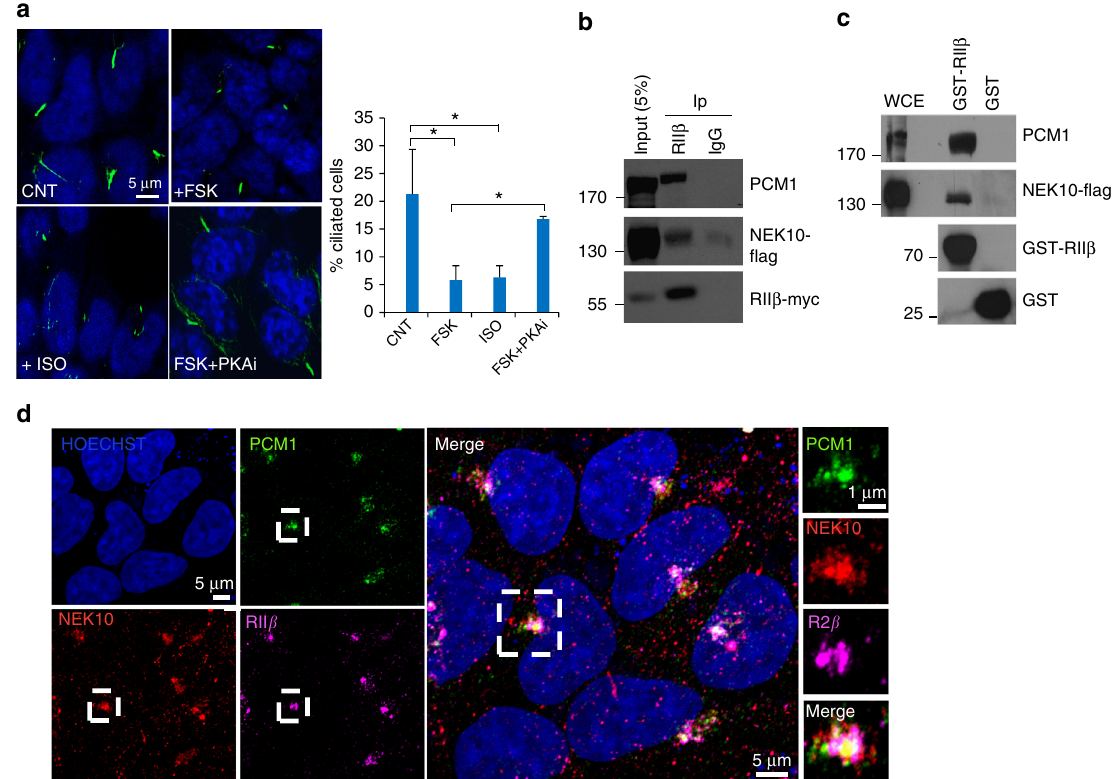
Fig. 1 Assembly of a pericentriolar kinase complex. a HEK293 cells were serum-deprived for 36 h and then left untreated (CNT) or stimulated for 3 h with isoproterenol (Iso) or forskolin (FSK) and doubly stained for acethylated tubulin and Draq5. Cumulative data from fi ve independent experiments are shown. * p < 0.05 (Student's t -test). Where indicated, the cells were pretreated for 30 min with the PKA inhibitor (PKAi) H89 (5 µ M) before stimulation. b RII β was immunopuri fi ed from whole-cell extracts (WCE). IgG was used as control. The precipitates and lysates were immunoblotted with anti-PCM1 and anti-RII β antibodies. c Lysates of NEK10- fl ag expressing cells were subjected to pull down assays with puri fi ed GST or GST – RII β fusion. The precipitates and lysates were immunoblotted with anti-PCM1, anti- fl ag and anti-RII β . d HEK293 cells were fi xed and immunostained for endogenous PCM1, NEK10, and RII β . A merge composite of the three signals and magni fi cation of a selected area are shown (right